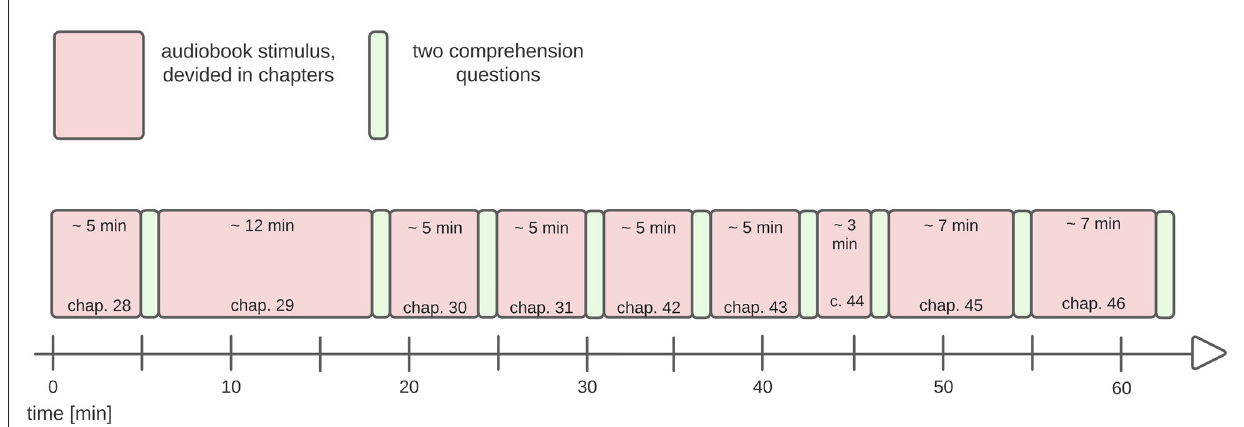
FIGURE3 Presentation scheme. The total duration of the protocol was ∼ 1h. The audio book was presented in 9 consecutive parts with an average duration of 6:26min per chapter. After each chapter, two comprehension questions were presented.